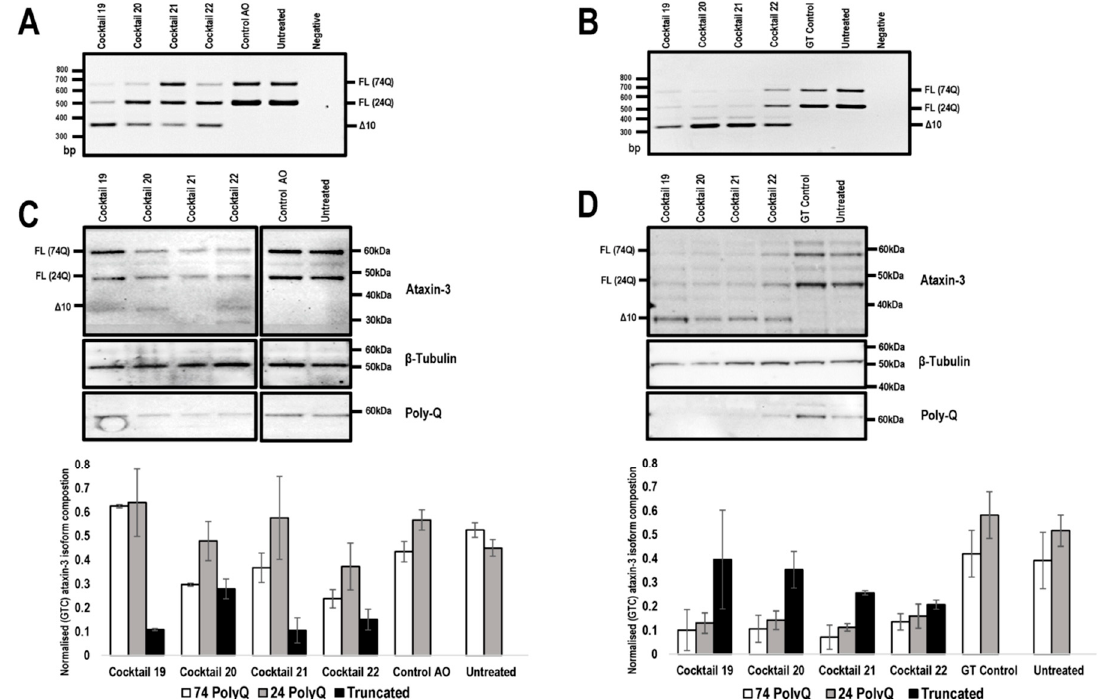
Figure 3. Comparison of ATXN3 exon 10 skipping in patient cells, transfected with 2 (cid:48) -Me PS AOs and PMOs. Cells were harvested 48 hr following transfection for protein and RNA analysis. Agarose gel fractionation of ATXN3 amplicons, following 2 (cid:48) -Me PS AO ( A ) and PMO ( B ) cocktail transfections at concentrations of 400 nM and 20 µ M, respectively shows full-length (FL 74Q; FL 24Q) and induced transcript products after skipping of exon 10 ( ∆ 10). Ataxin-3 protein was analysed by Western blotting following 2 (cid:48) -Me PS AO ( C ) and PMO ( D ) cocktail transfection at a concentration of 400 nM and 20 µ M, respectively. The disease-causing 74Q protein is approximately 60 kDa, the protein encoded by the healthy allele is approximately 48 kDa and the ∆ 10 encoded protein, 34 kDa. Beta-Tubulin was used as a loading control. The samples were also probed with an anti-polyglutamine antibody to identify the pathogenic stretch of glutamines in the ataxin-3 protein. Densitometric analysis performed on the Western blots are shown below the blots (means plus error bars. Error bars = standard deviation, n = 3). Samples are normalised to the GT control. (FL = full-length, ∆ 10 = exon skipped product, GT = Gene Tools control PMO, Q = glutamine, PolyQ =